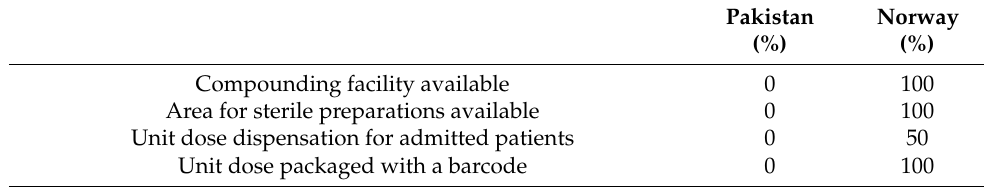
Table 7. Pharmacists’ assessments on preparing, packaging, and labeling medications.